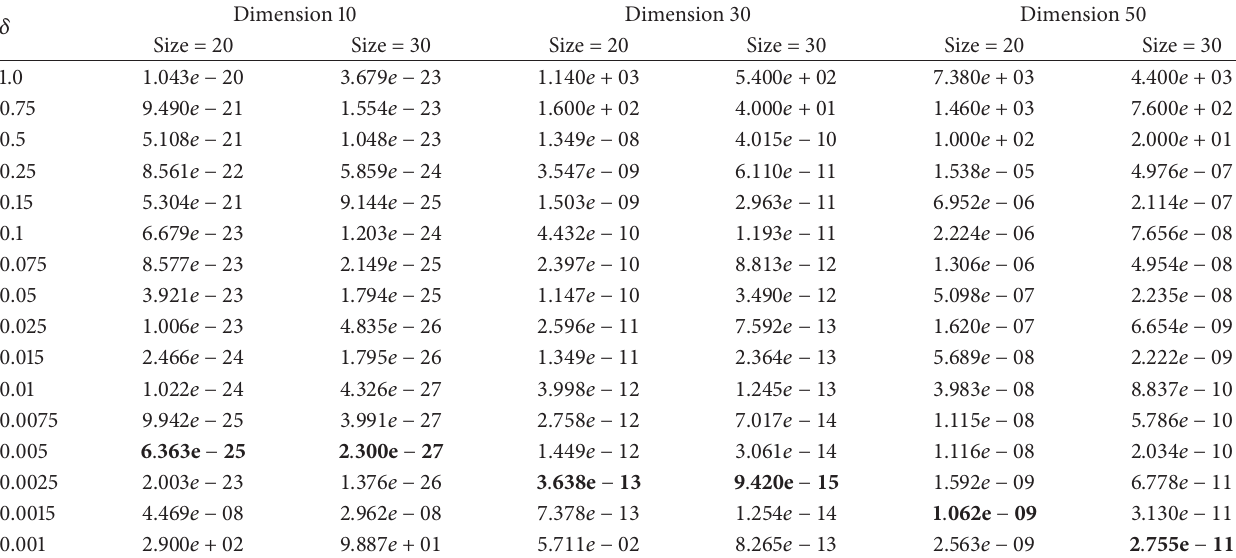
Table 12: Different values of parameter 𝛿 and respective mean best fitness for Sphere test